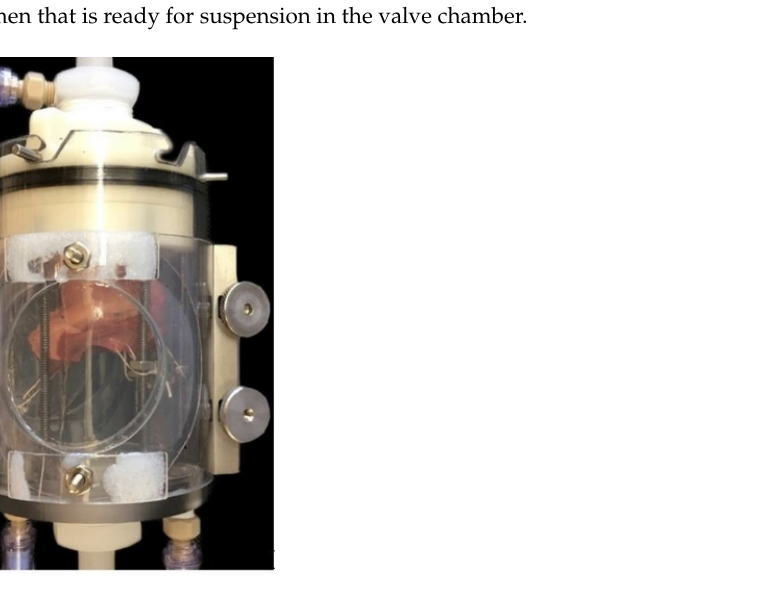
Figure 4. Actual photograph of porcine valve suspended in the valve chamber.